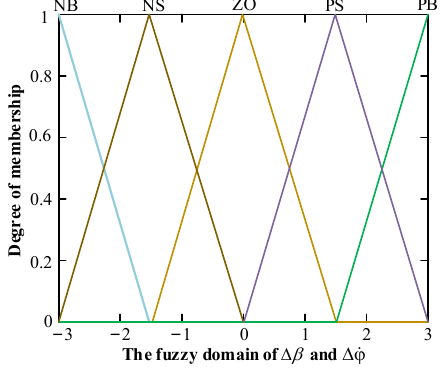
Processes 2022 , 10 , x FOR PEER REVIEW